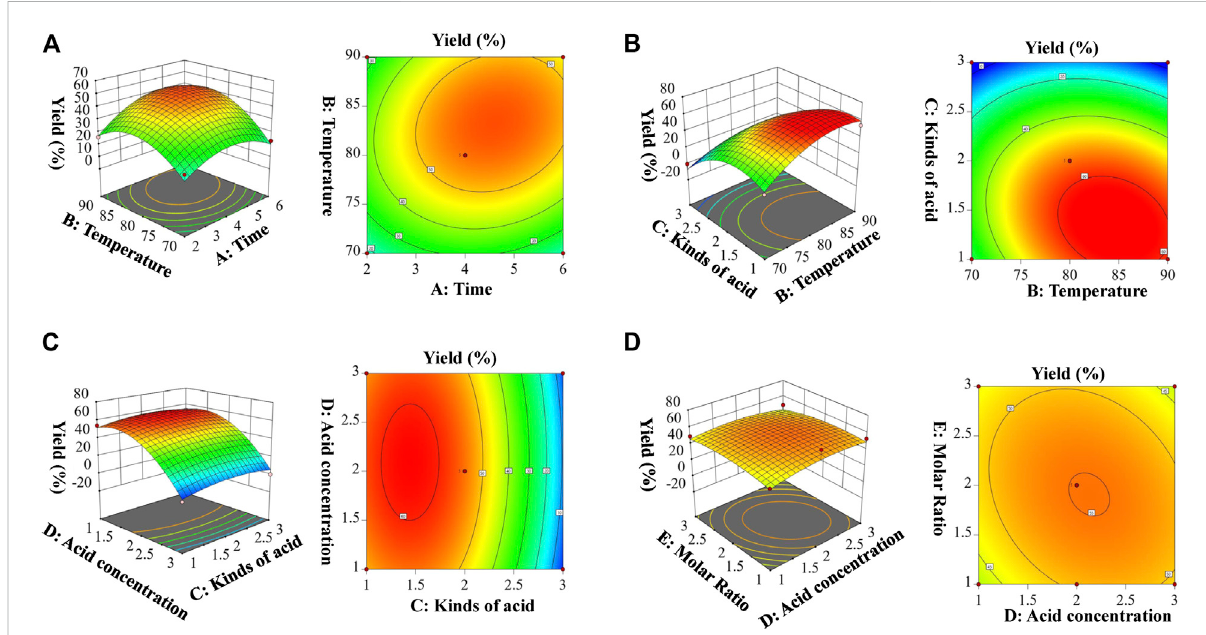
FIGURE 2 Response surface plots showing effects of variables on the derivatization of HAN. [ (A) . The response surface of the effect of exaction time (A, h) and temperature (B, ° C); (B) . The response surface of the effect of temperature (B, ° C) and kinds of acid (C); (C) . The response surface of the effect of kinds of acid (C) and acid concentration (D, eq); (D) . The response surface of the effect of acid concentration (D, eq) and molar Ratio (E, eq)].